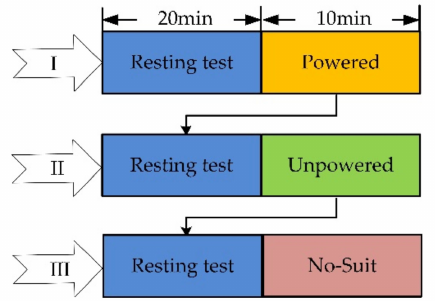
Figure 6. Scheme of assistance experiments. The subjects rested for 20 min before the test and walked in the state of Powered, Unpowered and No-Suit for 10 min.